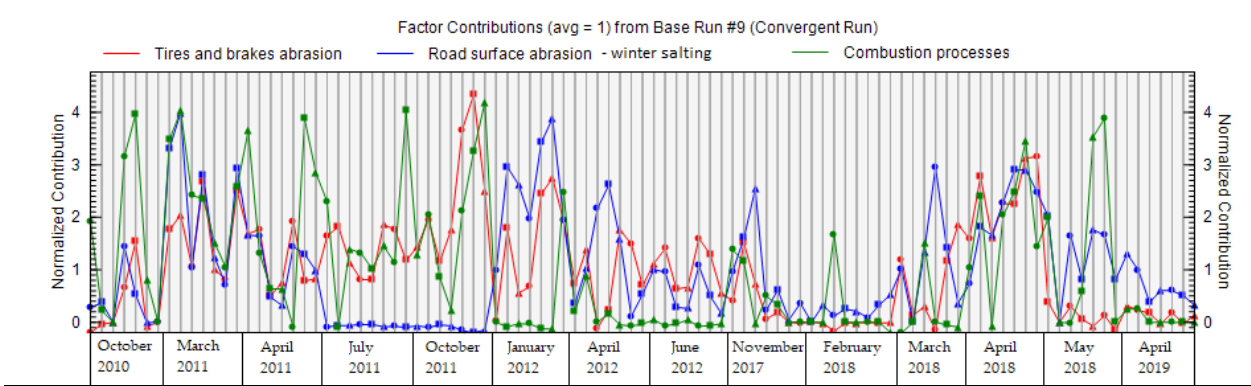
Figure 13. Contribution of factors during individual periods of PM 2.5–10 measurements in the city of